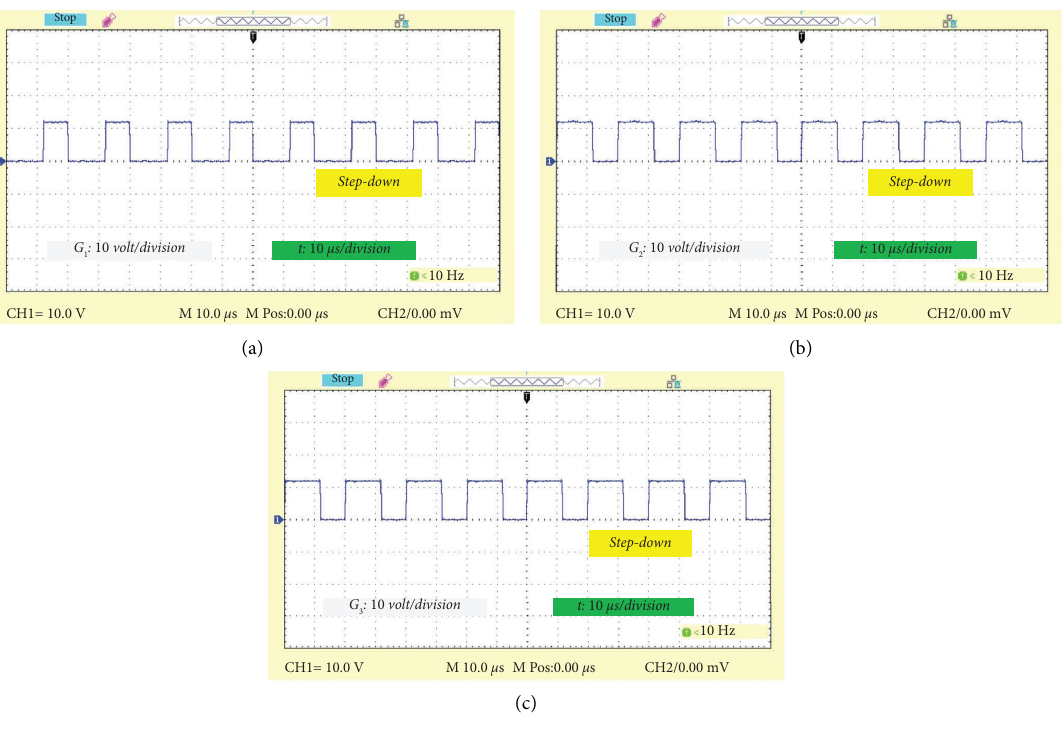
Figure 13: Gate pulse in step-down operation: (a) V